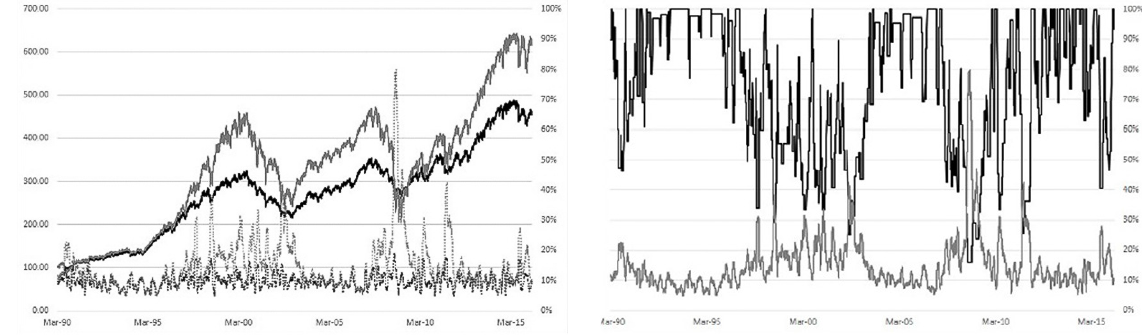
Figure 5. Comparative results for the TVS STD portfolio and the S&P 500 Note: The left side presents the path of TVS STD (solid black line) and of S&P 500 (solid gray line), and the TVS STD rolling standard deviation (dotted black line) and the S&P rolling standard deviation (dotted gray line). The right side presents how the equity exposure of the TVS STD (solid black line) changes with respect to the volatility of the S&P 500 (solid gray line).